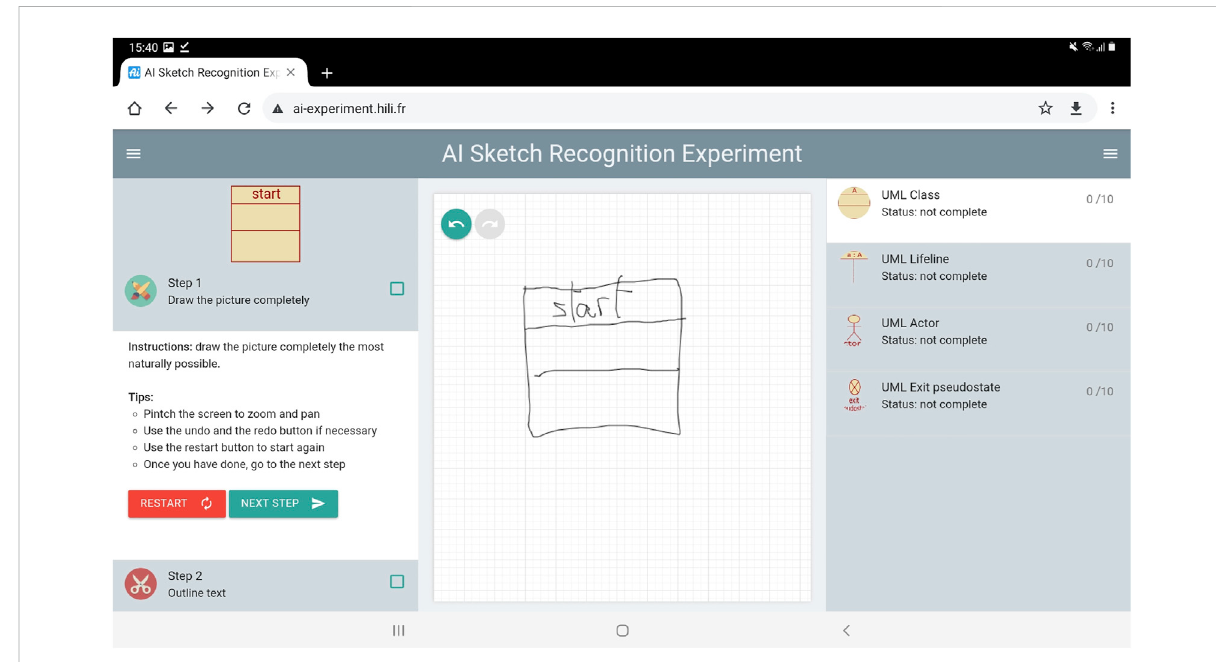
FIGURE 6 Overview of the training interface. It is used to train the neural network. The left sidenav shows indications to guide participants through the training. The right sidenav shows the progress of the participant. The main central area accepts pointer events to draw and touch events to navigate within the HTML5